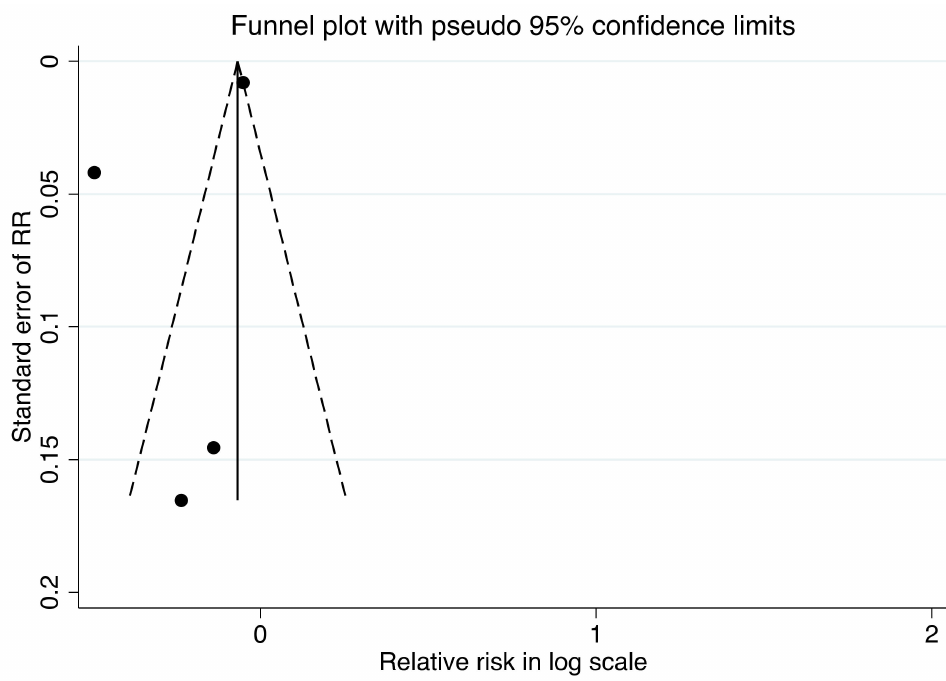
Figure 5. Funnel plot for association of oat intake with cardiovascular